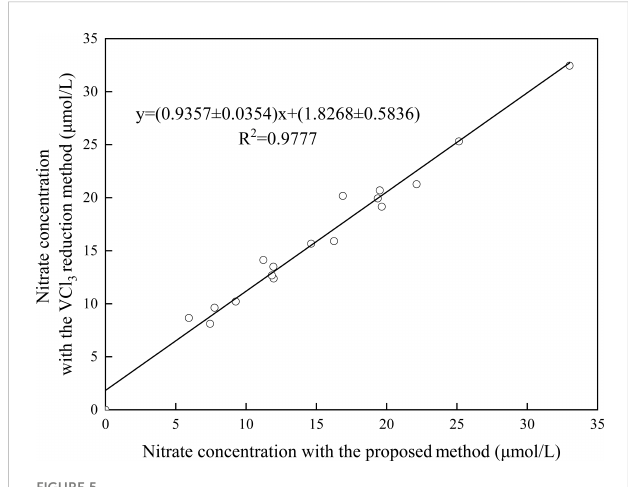
FIGURE 5 Comparison of the results obtained by the proposed method and the referred VCl 3 reduction method.